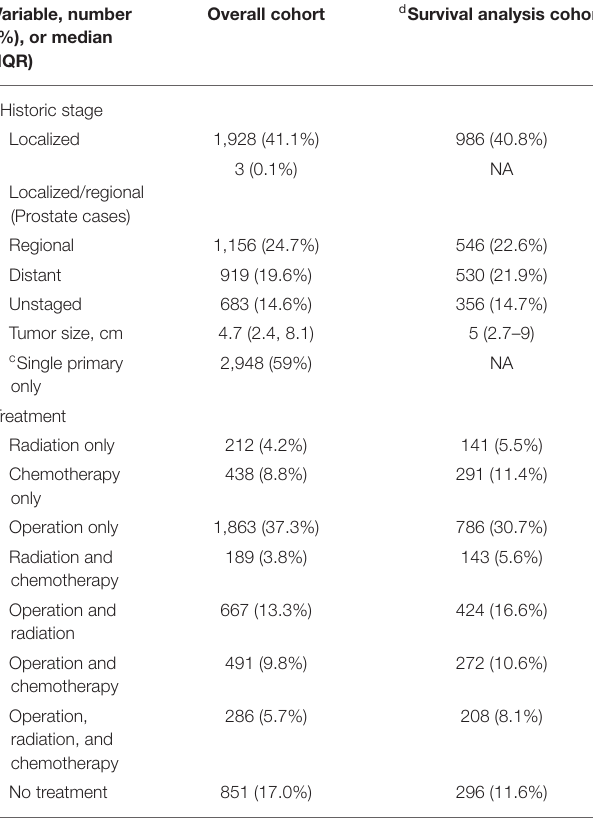
TABLE 1 | Patient demographics, tumor characteristics, treatments for all patients with angiosarcoma vs. survival analysis cohort in the Surveillance, Epidemiology, and End Results (SEER) database, 1975–2016. Variable, number